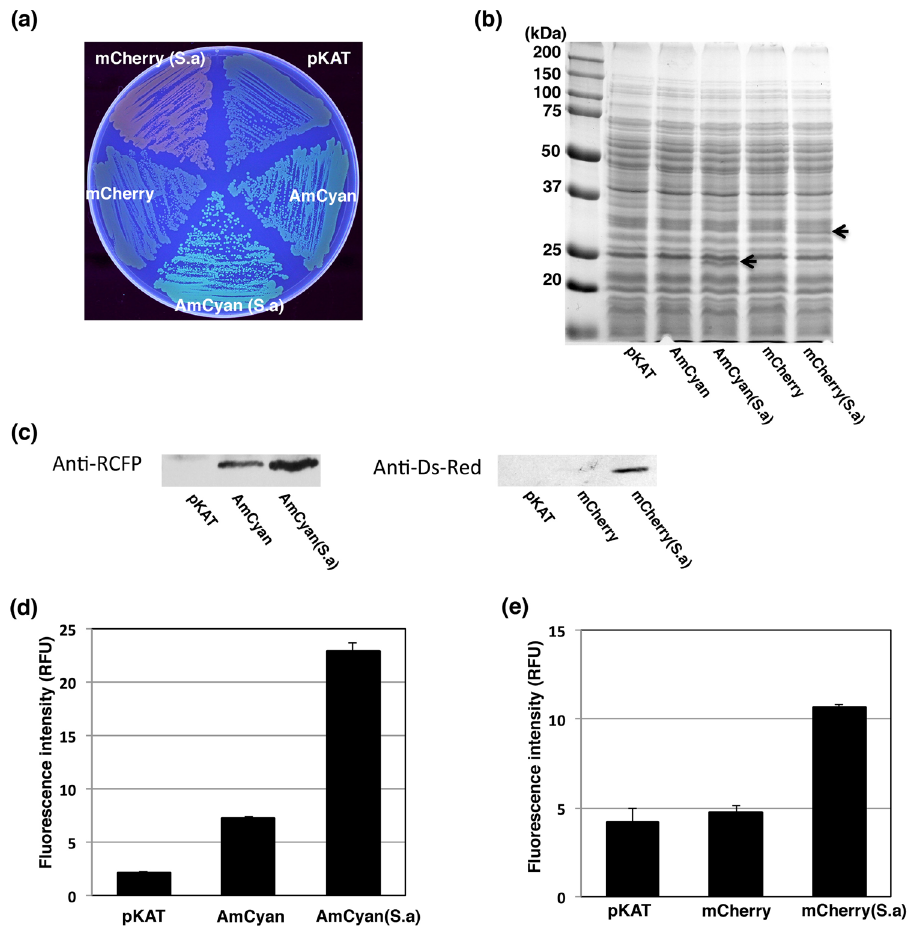
Figure 4. Codon usage optimization of the amCyan and mCherry genes. ( a ) The fluorescing colonies were photographed under UV excitation. S . aureus strain MW2 containing pKAT (control), pFK62 (AmCyan), pFK64 (AmCyan(S.a)), pFK63 (mCherry), and pFK65 (mCherry(S.a)) were grown on TSB agar plates containing chloramphenicol. ( b ) SDS-PAGE analysis showed the relative quantities of AmCyan and mCherry in the whole cell lysates. Arrows indicate the position of AmCyan and mCherry in gel. ( c ) Western blot analysis of AmCyan or mCherry in the whole cell lysates. The Western blot gels were cropped and the full-length image are included in Supplemental Fig. 5(d). The comparison of fluorescent intensities of pKAT (control), pFK62 (AmCyan), and pFK64 (AmCyan(S.a)) in S . aureus MW2. The fluorescent intensities at 489 nm were measured with a microplate reader, λ ex = 458 nm. The data represent mean values ± standard deviation. ( e ) The comparison of fluorescent intensities of pKAT (control), pFK63 (mCherry), and pFK65 (mChaerry(S.a)) in S . aureus MW2. The fluorescent intensities at 610 nm were measured with a microplate reader, λ ex = 586 nm. The data represent mean values ± standard